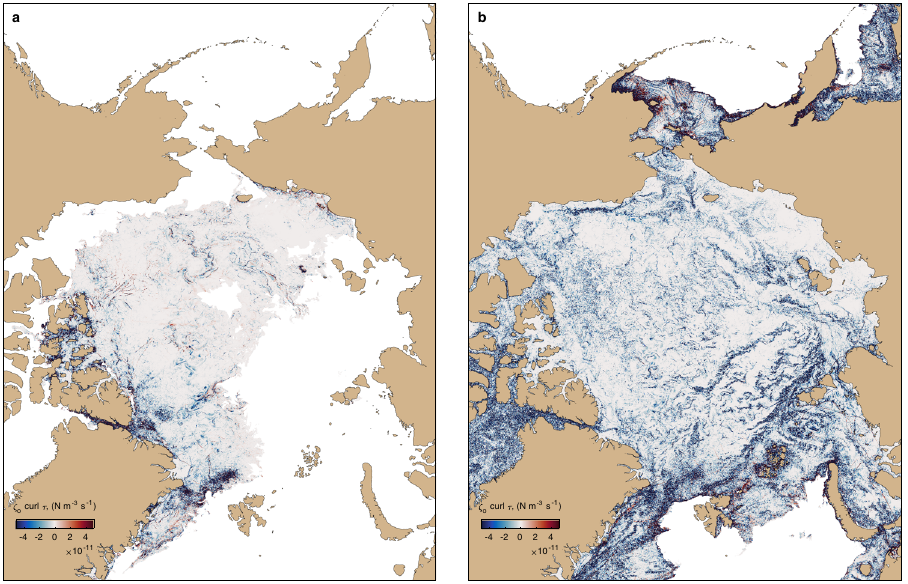
Fig. 4 Seasonal variation in the frictional dissipation rate of the ocean vorticity variance in the ice-ocean boundary layer. Distribution of instantaneous dissipation rate of upper-ocean (20 m depth) vorticity variance by frictional processes at the ice-ocean boundary layer ( ζ o ⋅ curl τ , see Eq. (2)) plotted for ( a ) the end of summer (1st September 2012), with close to minimum sea ice extent, and ( b ) the end of winter (1st March 2012), with close to maximum sea ice extent. Color bar limits are the same in both panels with negative values corresponding to vorticity variance dissipation. The spatially-averaged dissipation rate is a factor of 6 larger in March as compared with September. Dissipation rates are enhanced at the continental shelf breaks and other regions of strong eddy kinetic energy, e.g., over the Lomonosov Ridge or in the Fram